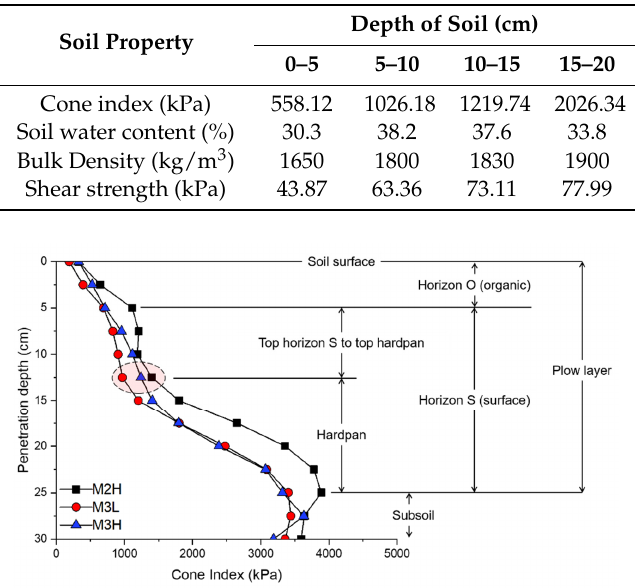
Table 4. Descriptive statistics of the measured tillage depth (cm) during plow tillage. Gear Selection (Working Time, Sec) Mean Max.